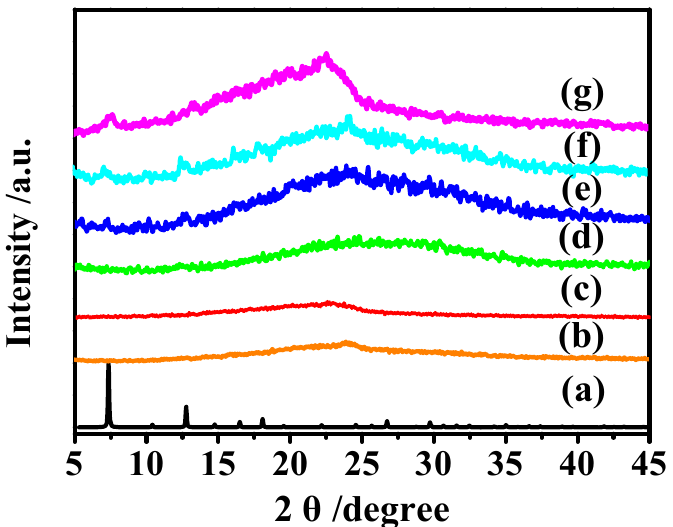
Figure 4. XRD patterns of ( a ) simulated MAF ‐ 7, ( b ) P, ( c ) PM 1, ( d ) PM 3, ( e ) PM 5, ( f ) PM 7, and ( g )